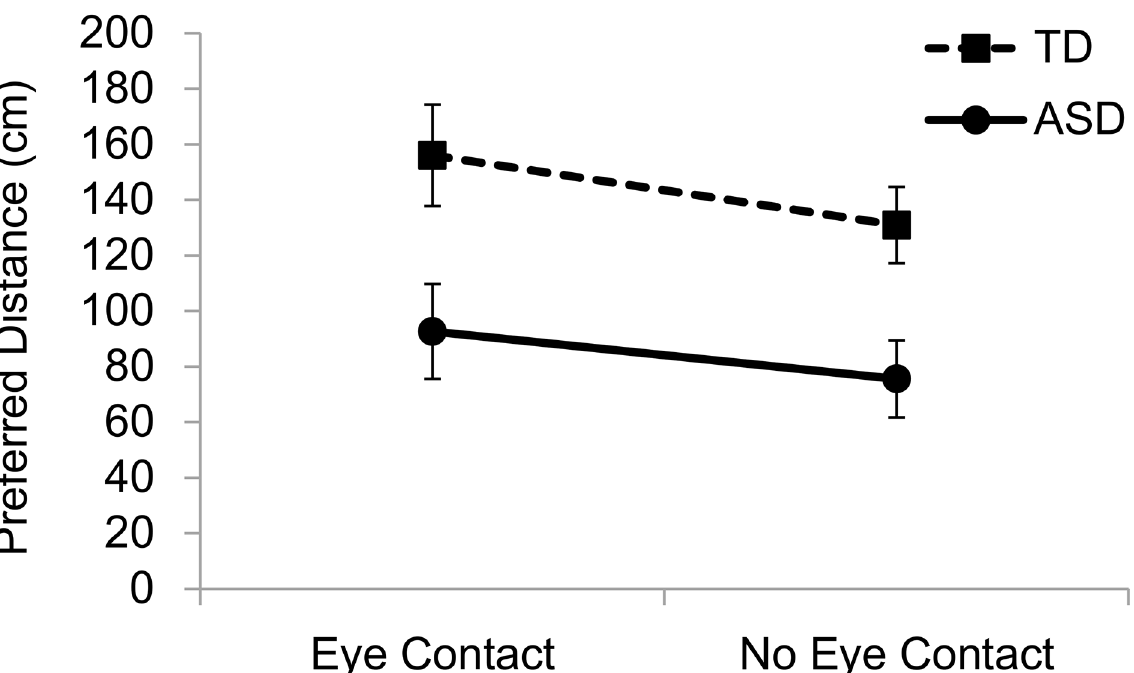
Fig 1. Mean preferred distances from another person when the other person approached. ASD, autism spectrum disorder; TD, typically developing. Error bars indicate standard errors of the mean.